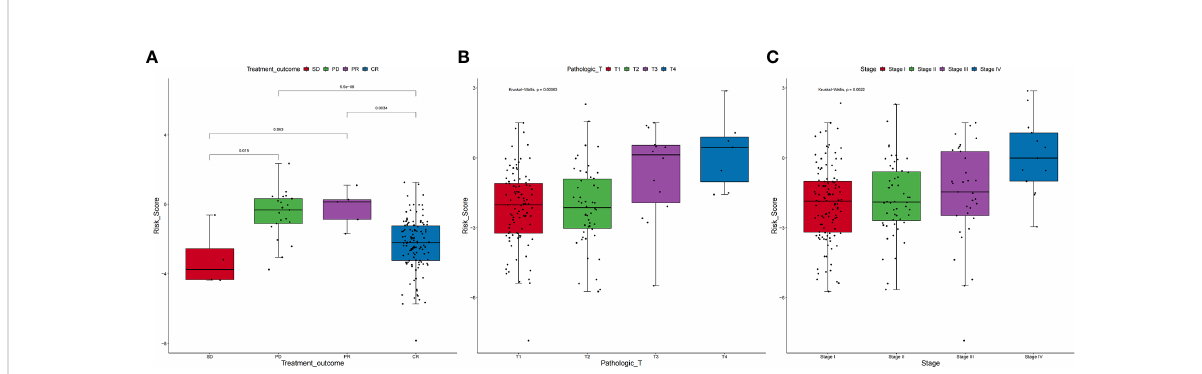
FIGURE 4 Correlation between clinical characteristics and risk scores. (A) Based on the analysis of the relationship between treatment outcome and risk scores, it can be seen that risk score was relatively high in the PD group and low in the SD group, but the median risk score was the highest in the PR group. Moreover, there were statistical differences between the SD and PD groups, the PD and CR groups, and the PR and CR groups. (B) On the relationship between Pathologic_T and risk scores, it can be seen that risk score was relatively high in T4 and low in T1, but the median risk score was the lowest in T2. (C) On the relationship between stage and risk scores, it can be seen that risk score was relatively high in stage IV and low in stage I, but the median risk score was the lowest in stage